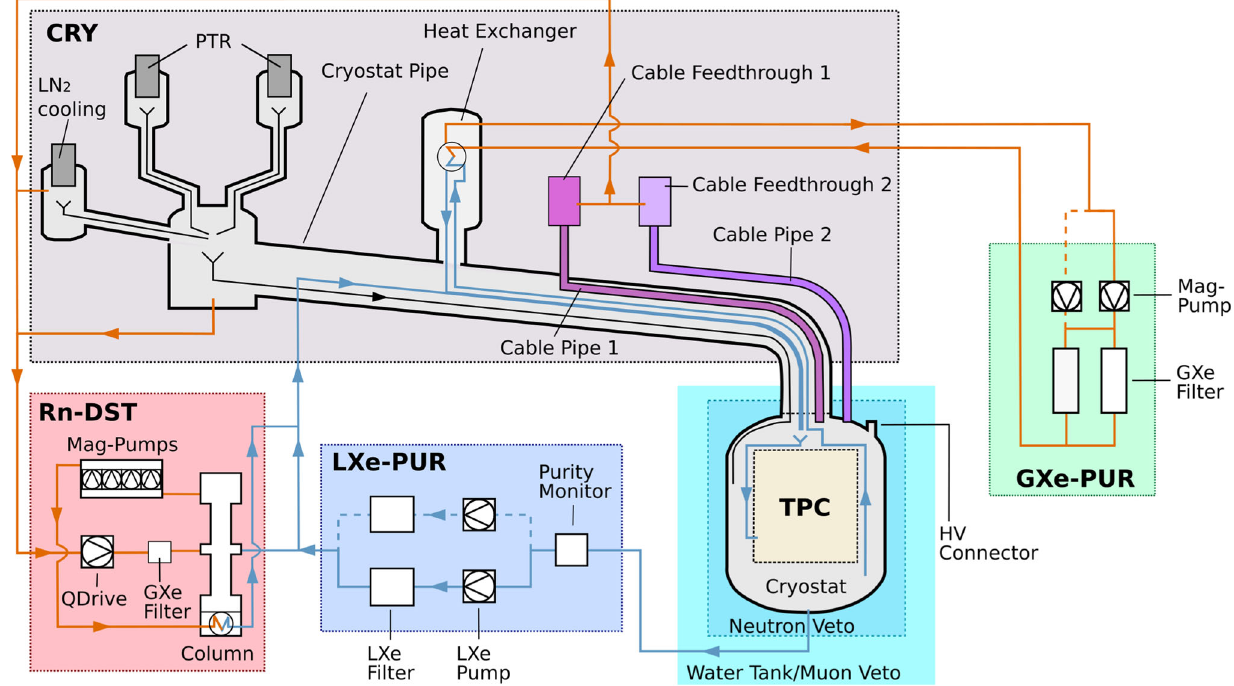
Fig. 2 Schematic drawing of the xenon handling system and the TPC of XENONnT. The circulation of xenon through the purification systems is indicated with orange (GXe) and blue (LXe) flow lines